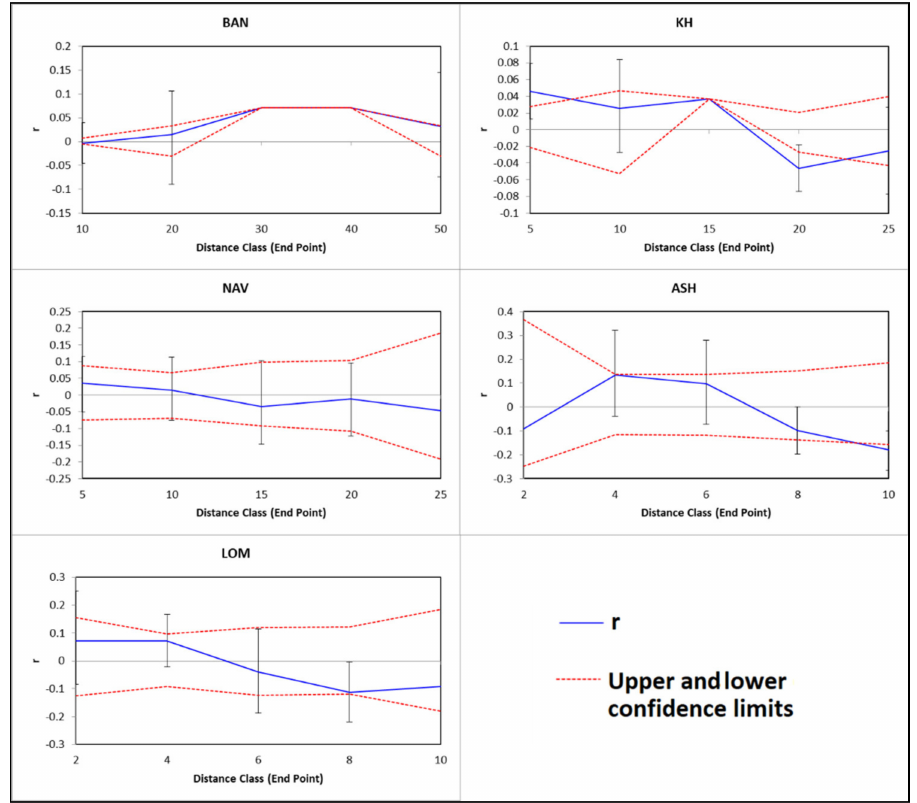
Figure 5. Correlograms illustrating spatial autocorrelation for all analyzed populations. Upper and lower error bars bound the 95% confidence interval to r, as determined by bootstrap